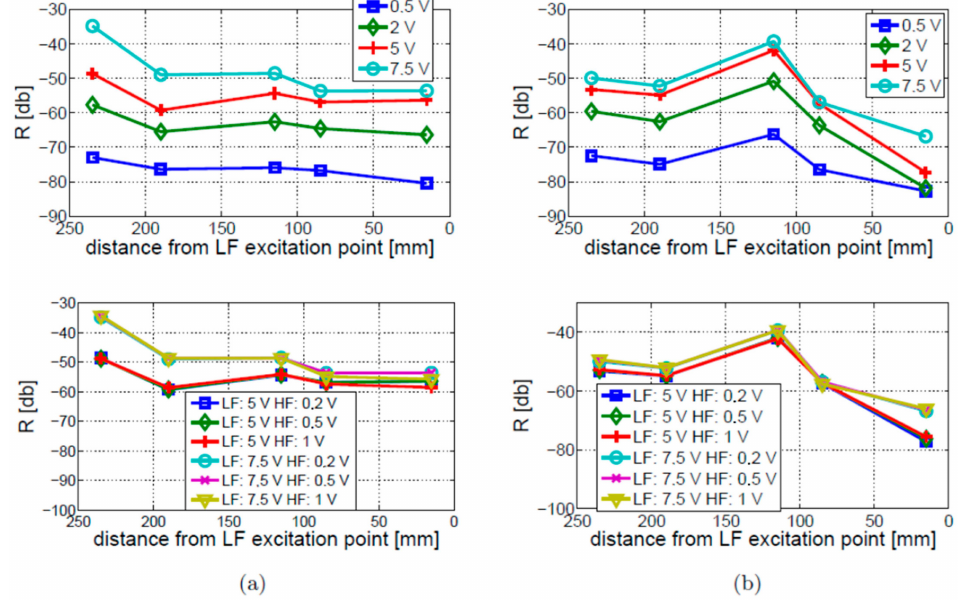
Figure 21. Study of LF vibration (top figures) and HF ultrasonic (bottom figures) excitation amplitude study for ( a ) intact beam; ( b ) cracked beam. Voltage excitation levels are indicated in the legends.